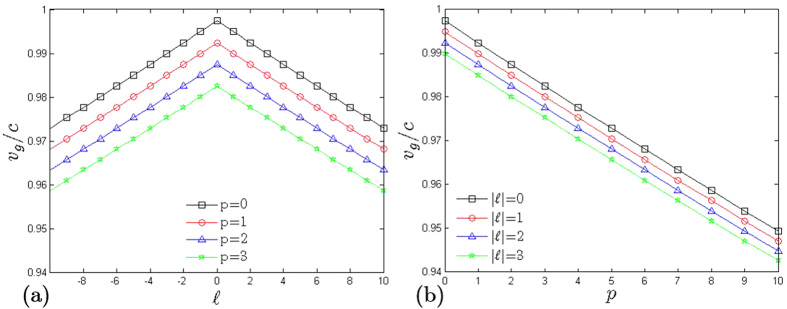
Plots of (a) vg/c versus  for different p values and (b) vg/c versus p for different  values.